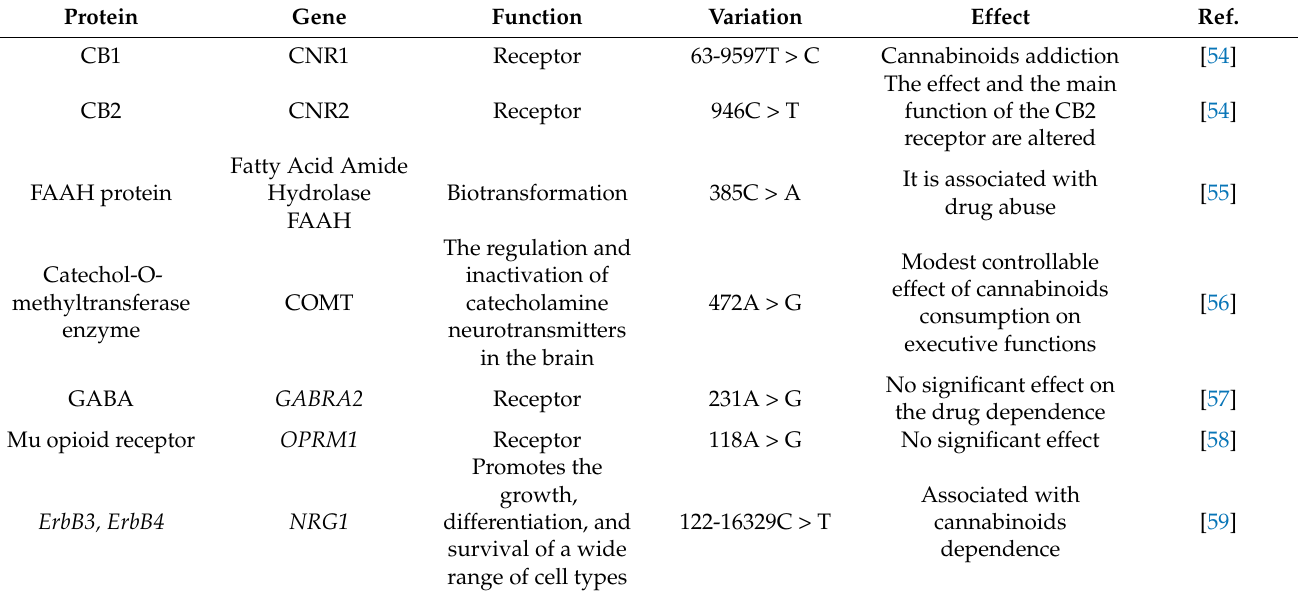
Table 2. Genetic variation and their relation to cannabinoids